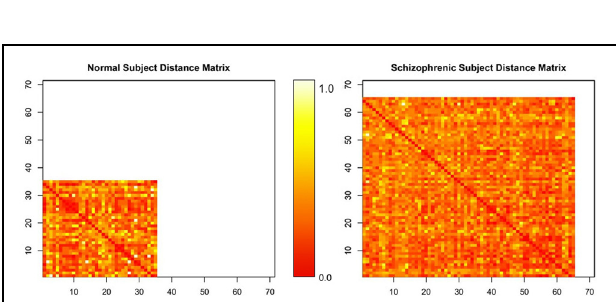
FIGURE 4 | Normalized distance matrices of two subjects, where rows and columns correspond to components within a subject and the intensity represents the functional connectivity between those